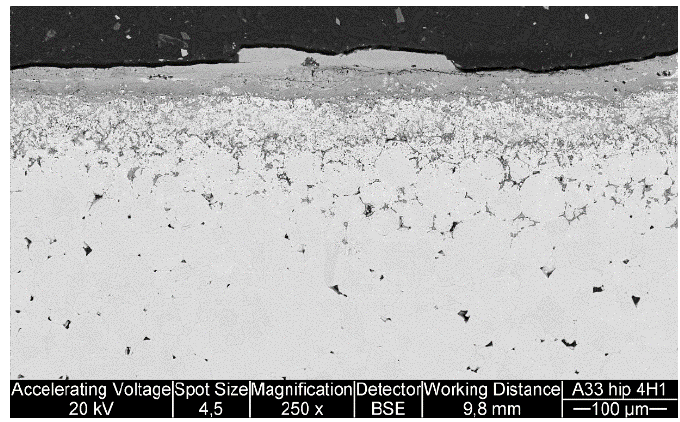
Figure 10. SEM image of HIP (FeNiCrAl) cross-section.